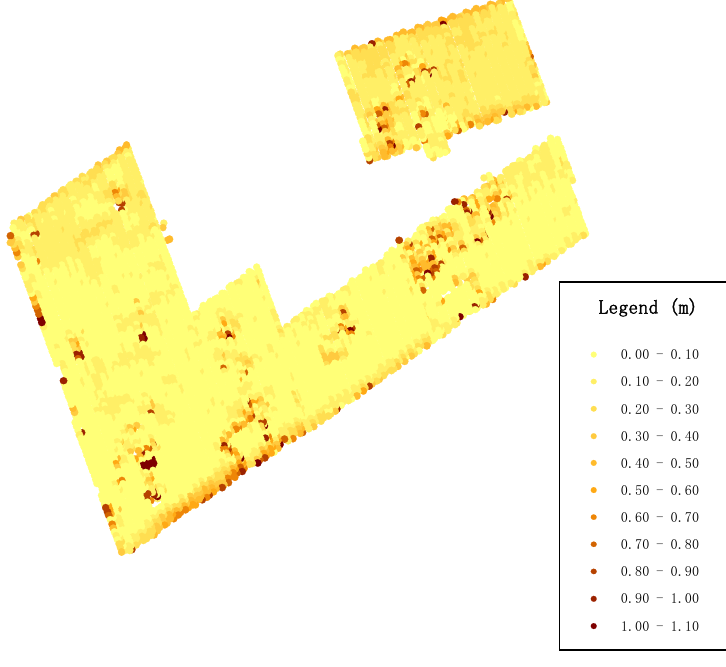
Figure 7. Residuals of overlap zone-2 after registration.